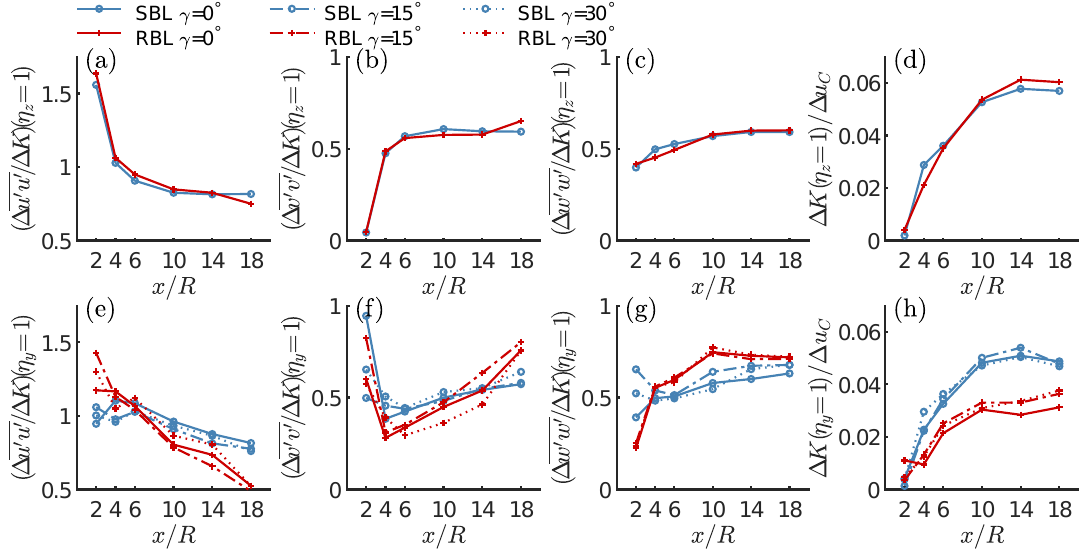
u (cid:48) / ∆ K )( η = 1 ) and ∆ K ( η = 1 ) / ∆ u C in the wake of the model i i